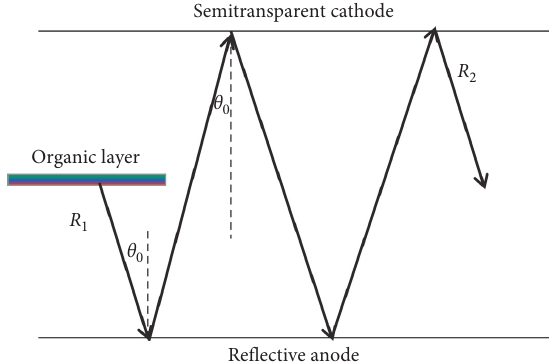
Figure 3: Microcavity structure of OLED microdisplay.